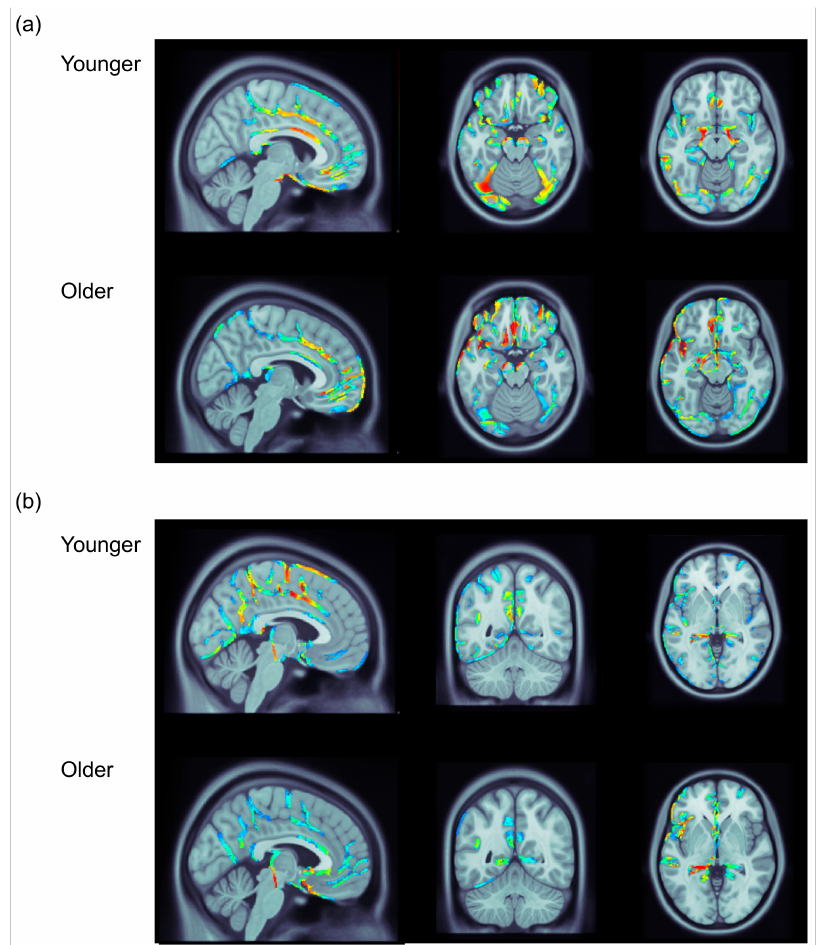
Figure 3. Results of the distributed source analysis for younger and older adults at the peak of the components for the relevant group. ( a ) Results for the FN, with the left panel demonstrating activity along the ACC, the middle panel demonstrating activity in the occipital region in both groups and the medial frontal region in older adults, and the right panel demonstrating activity in the middle temporal region. ( b ) Results for the P3a, with the left panel demonstrating activity along the ACC, and dorsomedial frontal cortex in younger adults, the middle panel demonstrating activity in the posterior cingulate and posterior insula, and the right panel demonstrating activity in the parahippocampal region. Moving from darker blue to red represents increasing